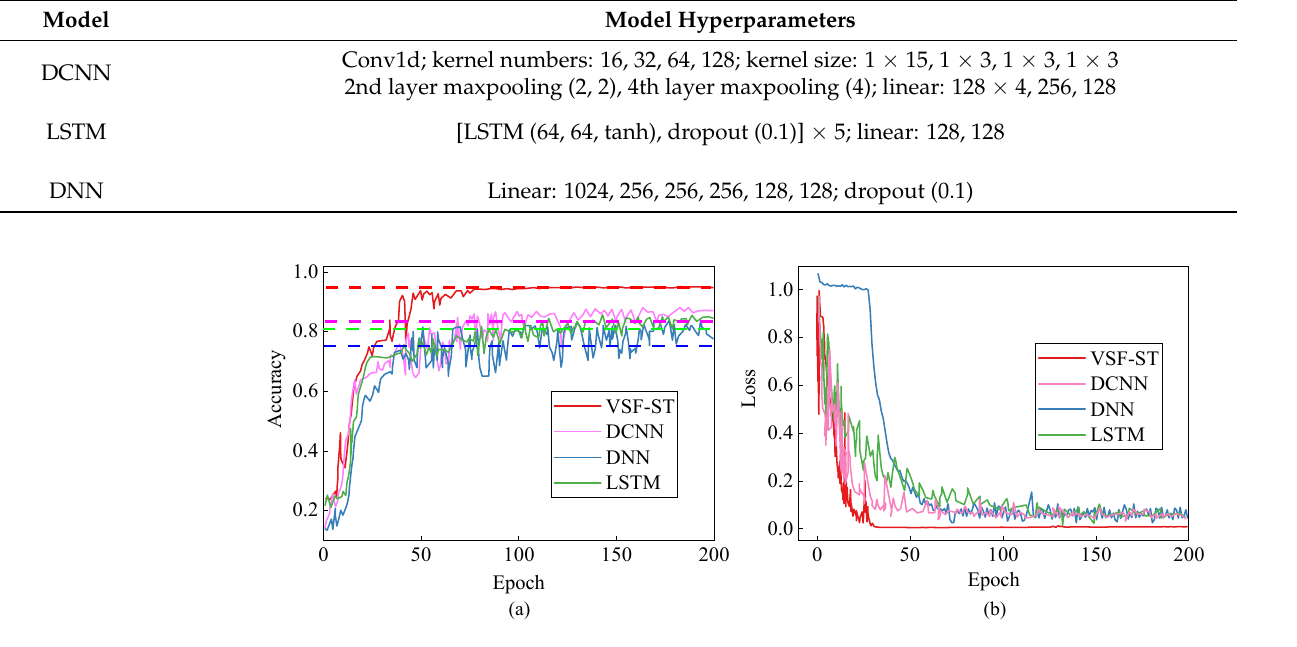
Figure 11. Comparison experiments based on SQV dataset: ( a ) accuracy curve; ( b ) loss curve.